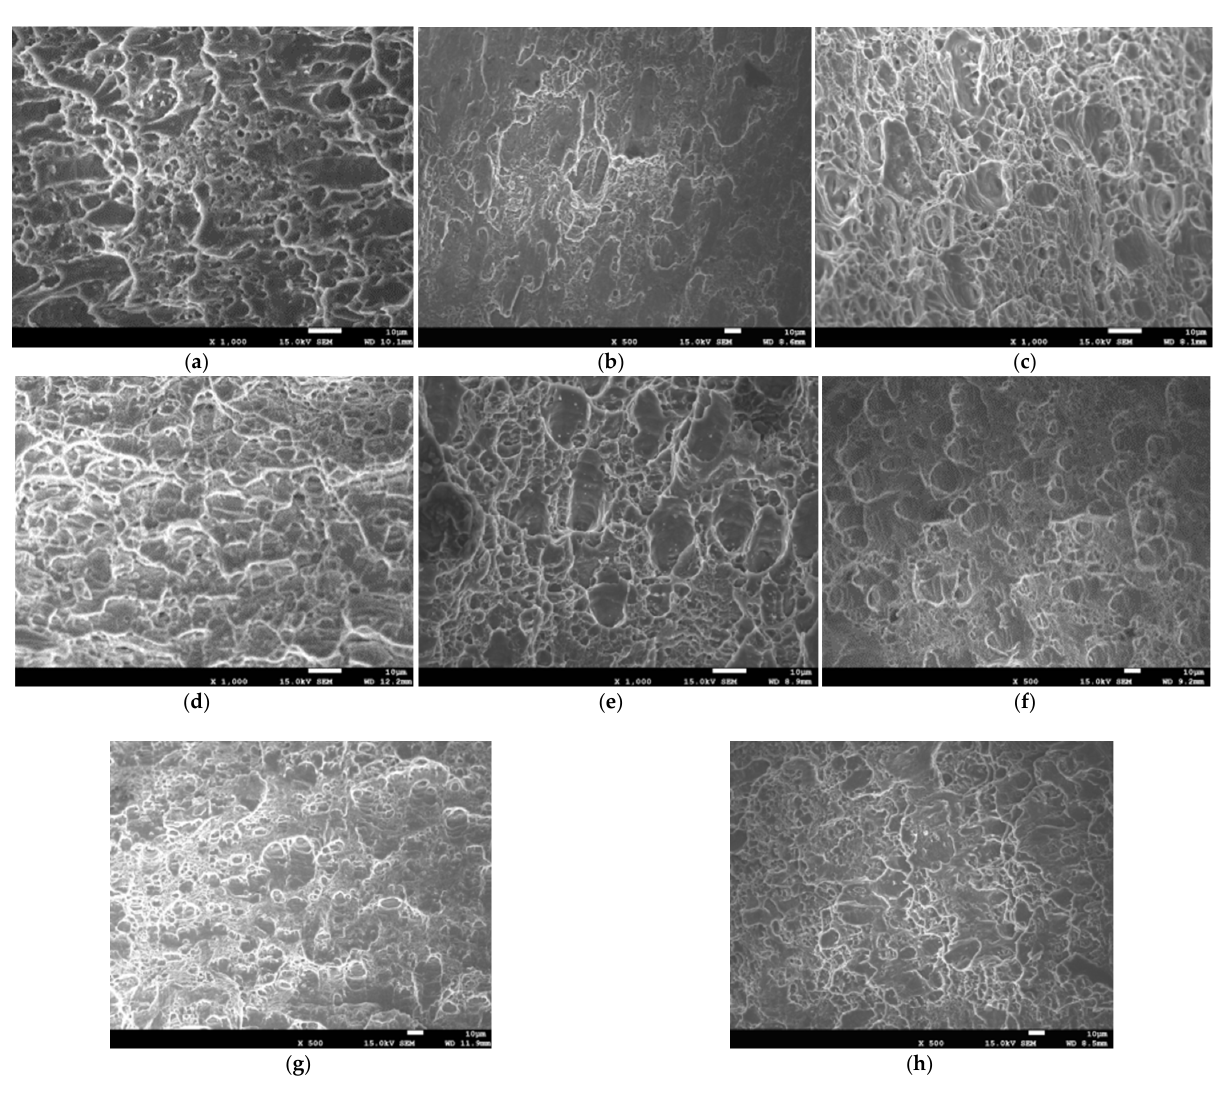
Figure 9. The microfracture morphology of SEM for different tension samples. ( a ) Circular arc tensile sample. ( b ) Shear sample. ( c ) R = 5 mm. ( d ) R = 8 mm. ( e ) R = 15 mm. ( f ) α = 60°. ( g ) α = 90°. ( h ) α = 120°.